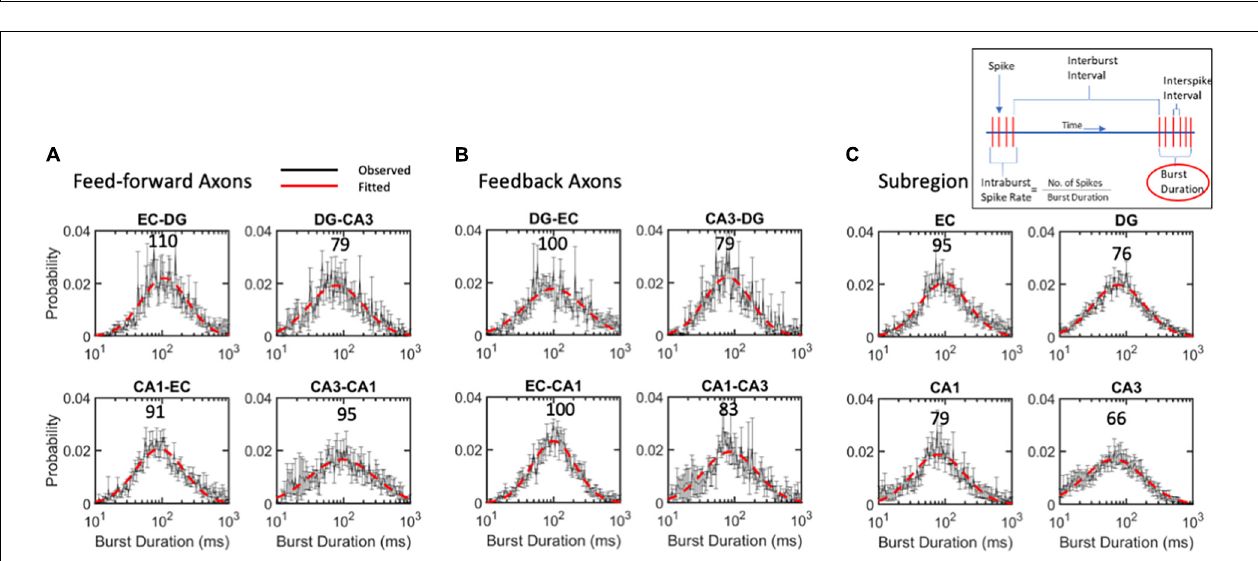
FIGURE 7 | Burst duration varies over 2-order of magnitude with similar log-normal modes of 88 ms for (A) feed-forward axons, (B) feedback axons or (C) subregions. ANOVA with Tukey HSD indicated no significant differences between distributions. Error bars at each intra-burst bin are SE for n = 10 arrays. Red dashed line is best fit of a single Gaussian distribution. Modes in ms are indicated above curves. All R 2 of fits > 0.9.